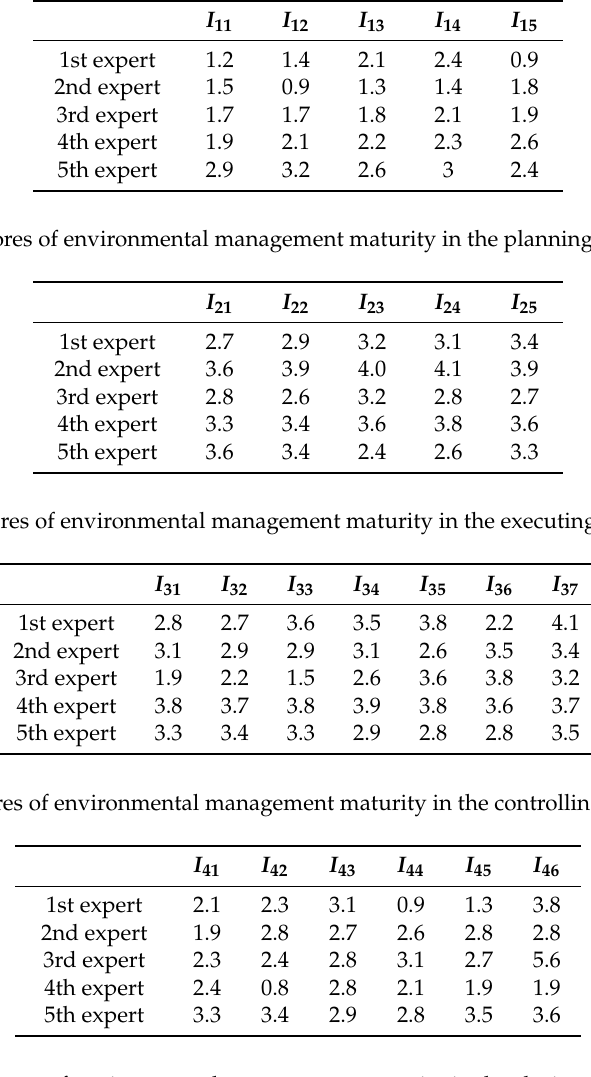
Table A21. Scores of environmental management maturity in the closing process index.